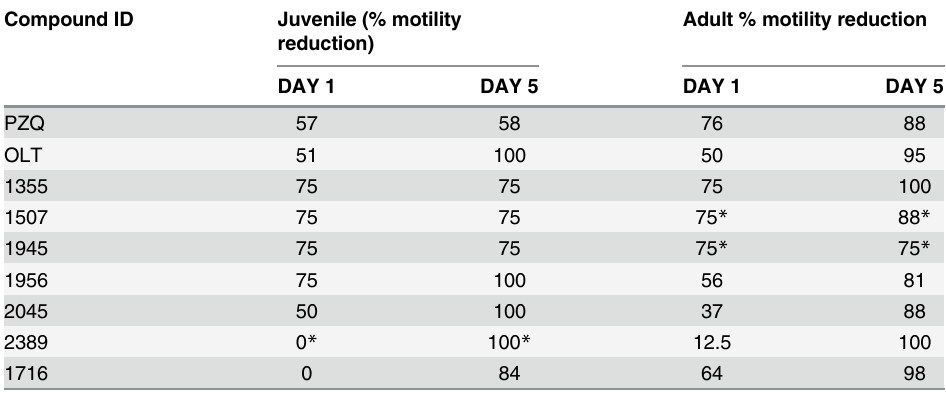
Table 4. Inhibition of worm motility at day 1 and day 5. Compound